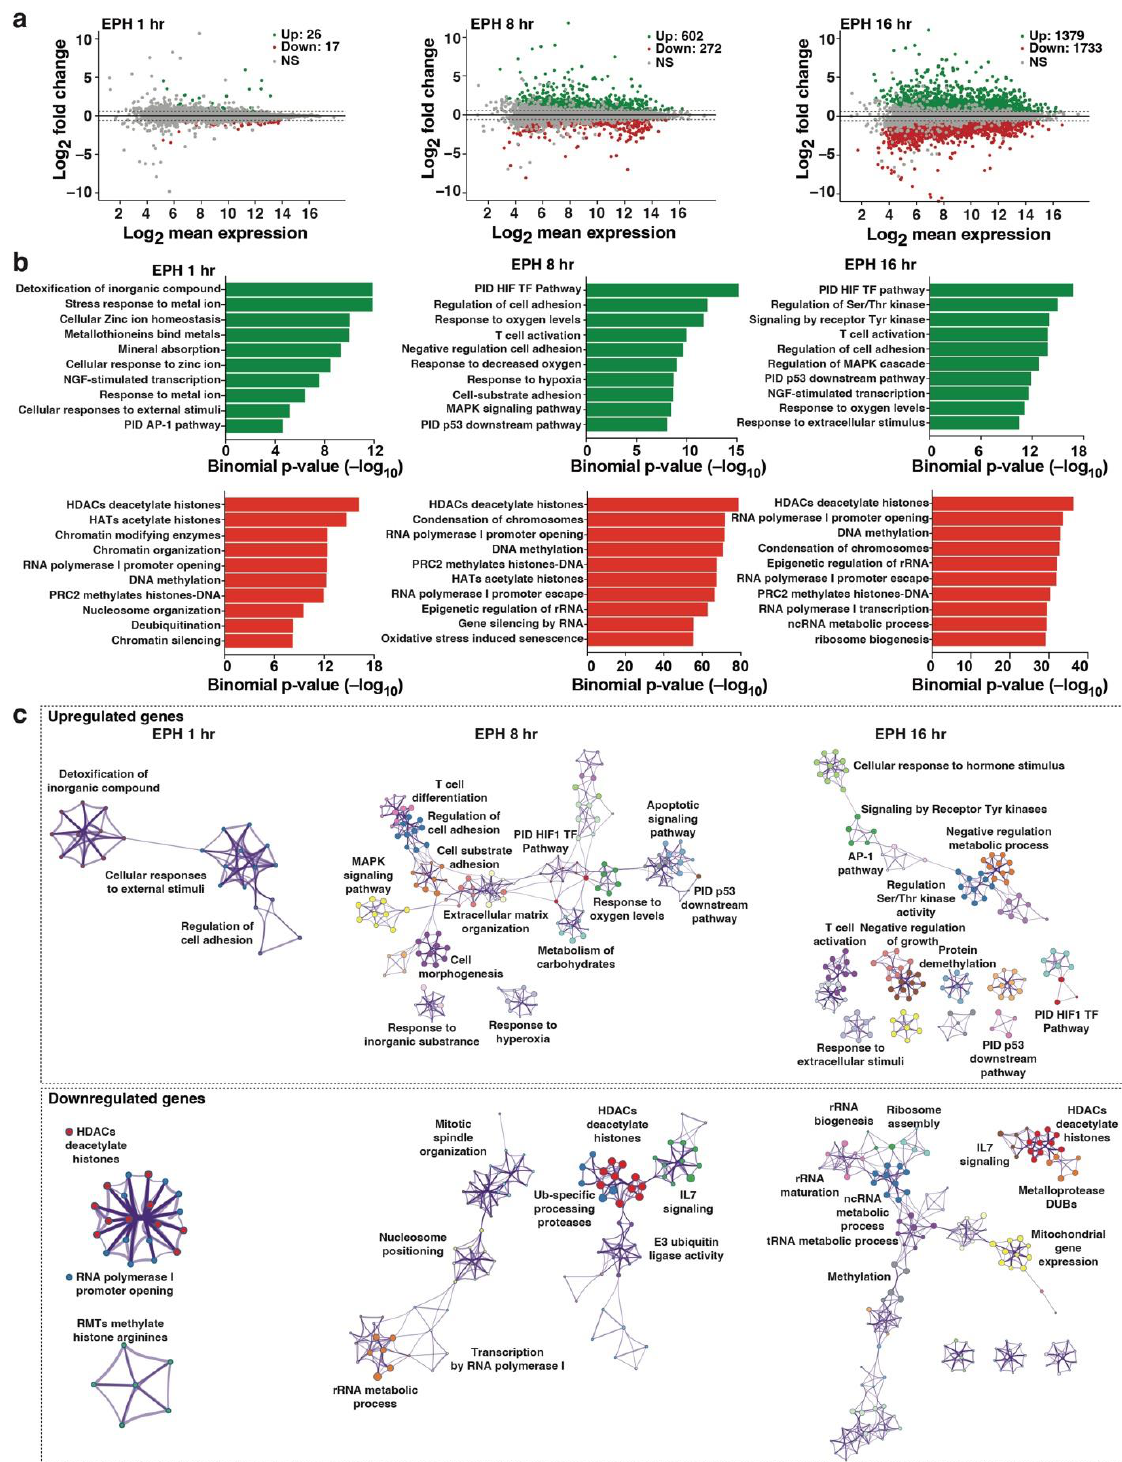
Figure 3. Transcriptional profiling reveals rapid activation of oxidative stress and hypoxia, leading to activation of master transcriptional regulators. ( a ) Scatterplots of the differentially expressed genes identified by RNA-seq of J-Lat 10.6 cells treated with EPH334 (2.5 μ M) for the indicated time points ( n = 3, false discovery rate [FDR] < 0.05). The number of upregulated (Up), downregulated (Down), and not statistically significant (NS) genes is indicated in each plot. ( b ) Functional annotation of biological processes enriched at upregulated and downregulated genes for the indicated time points. ( c ) Metascape enrichment network visualization showing the intracluster and